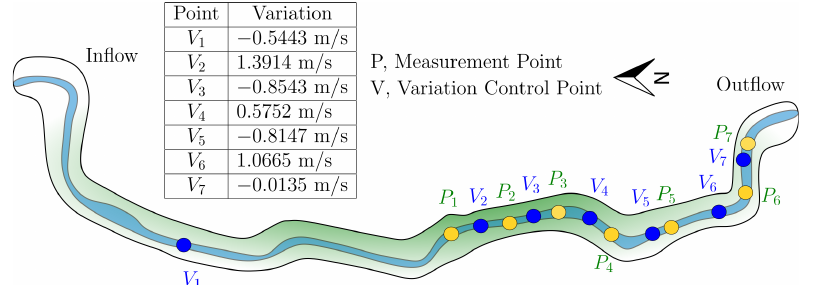
Figure 7. Location of flow variations in the model. Image designed with Inkscape.